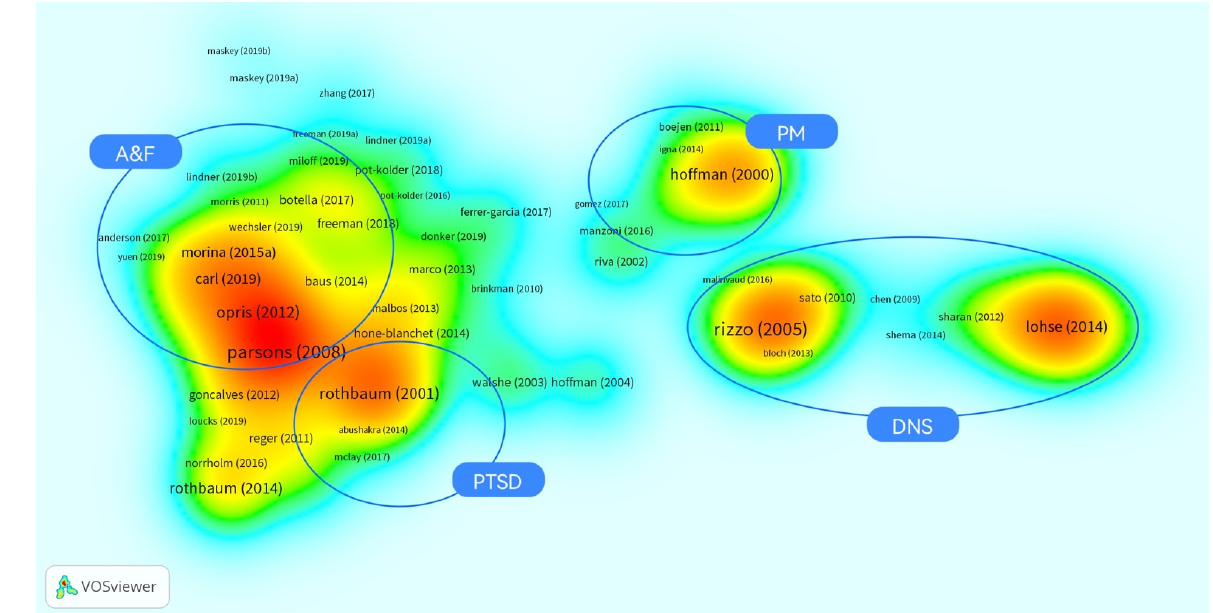
Figure 3. Density visualization of bibliographic coupling analysis of the theme of VR and therapy in the WoSc via VOSviewer (devised and generated by the authors).